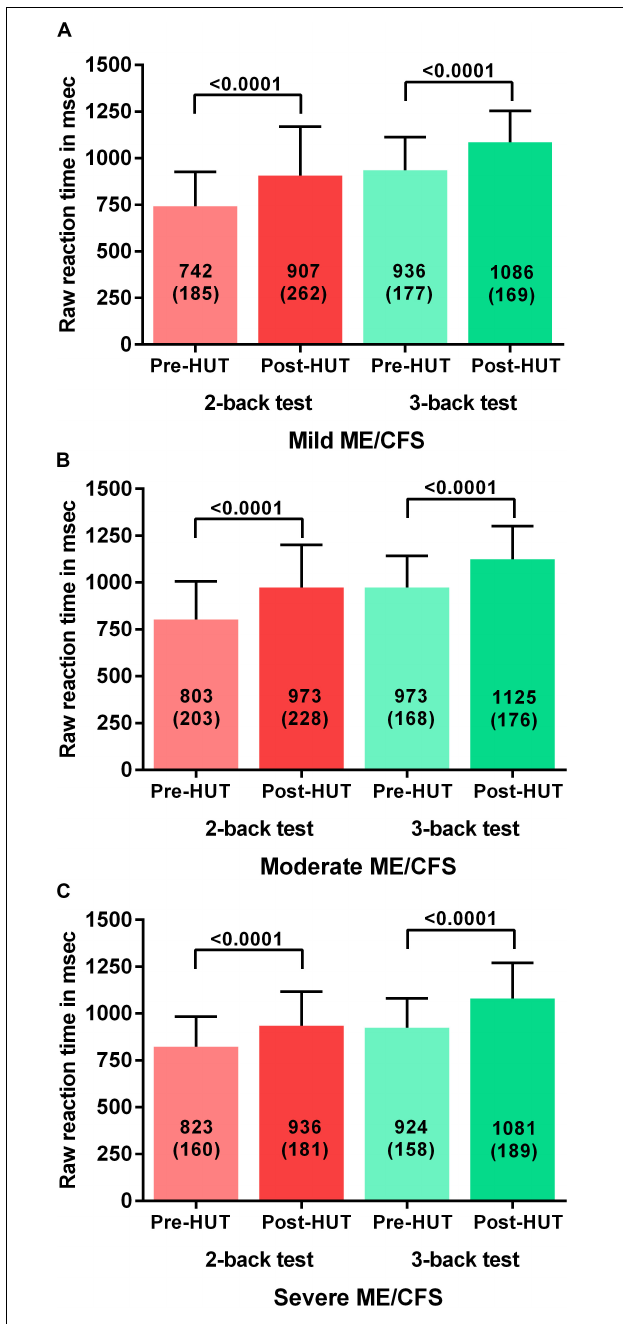
FIGURE 4 | Shows the raw reaction time on 2-back an 3-back test before and after head-up-tilt testing, for the three disease severity grading of ME/CFS: patients with mild disease (A) , moderate disease (B) , and severe disease (C) . HUT: head-up tilt test.